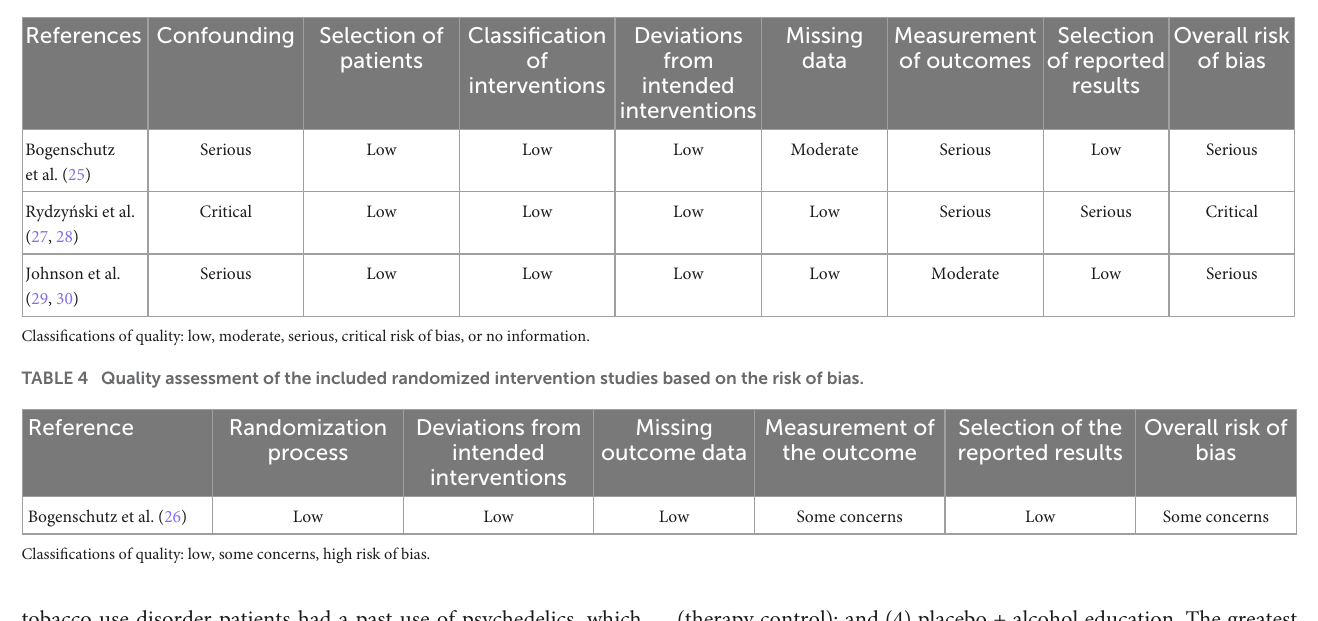
TABLE 3 Quality assessment of the included non-randomized intervention studies based on the risk of bias.